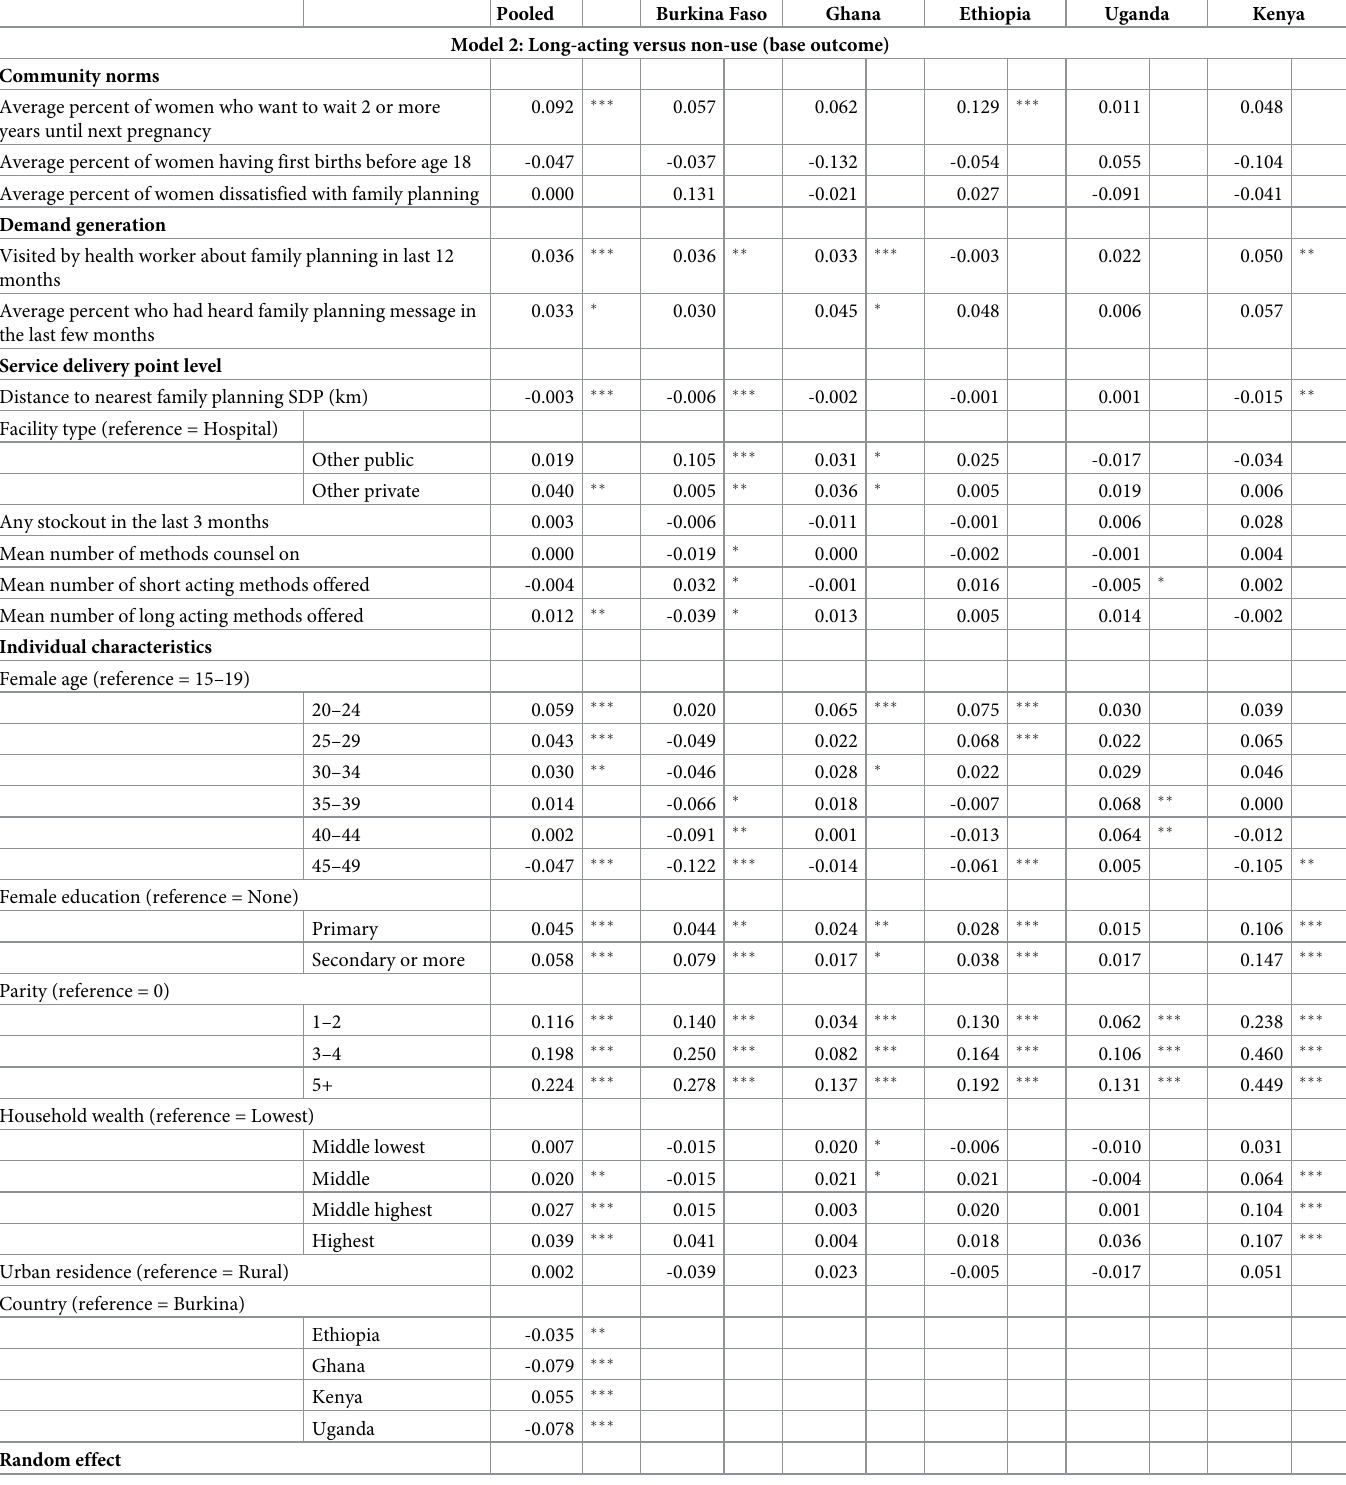
Table 4. Average marginal effects from the multilevel multinomial logistic regression model of individual women’s probability of long-acting contraceptive use on community, demand generation, and service delivery point variables adjusted for individual level socioeconomic characteristics, by country. Pooled Burkina Faso Ghana Ethiopia Uganda Kenya Model 2: Long-acting versus non-use (base